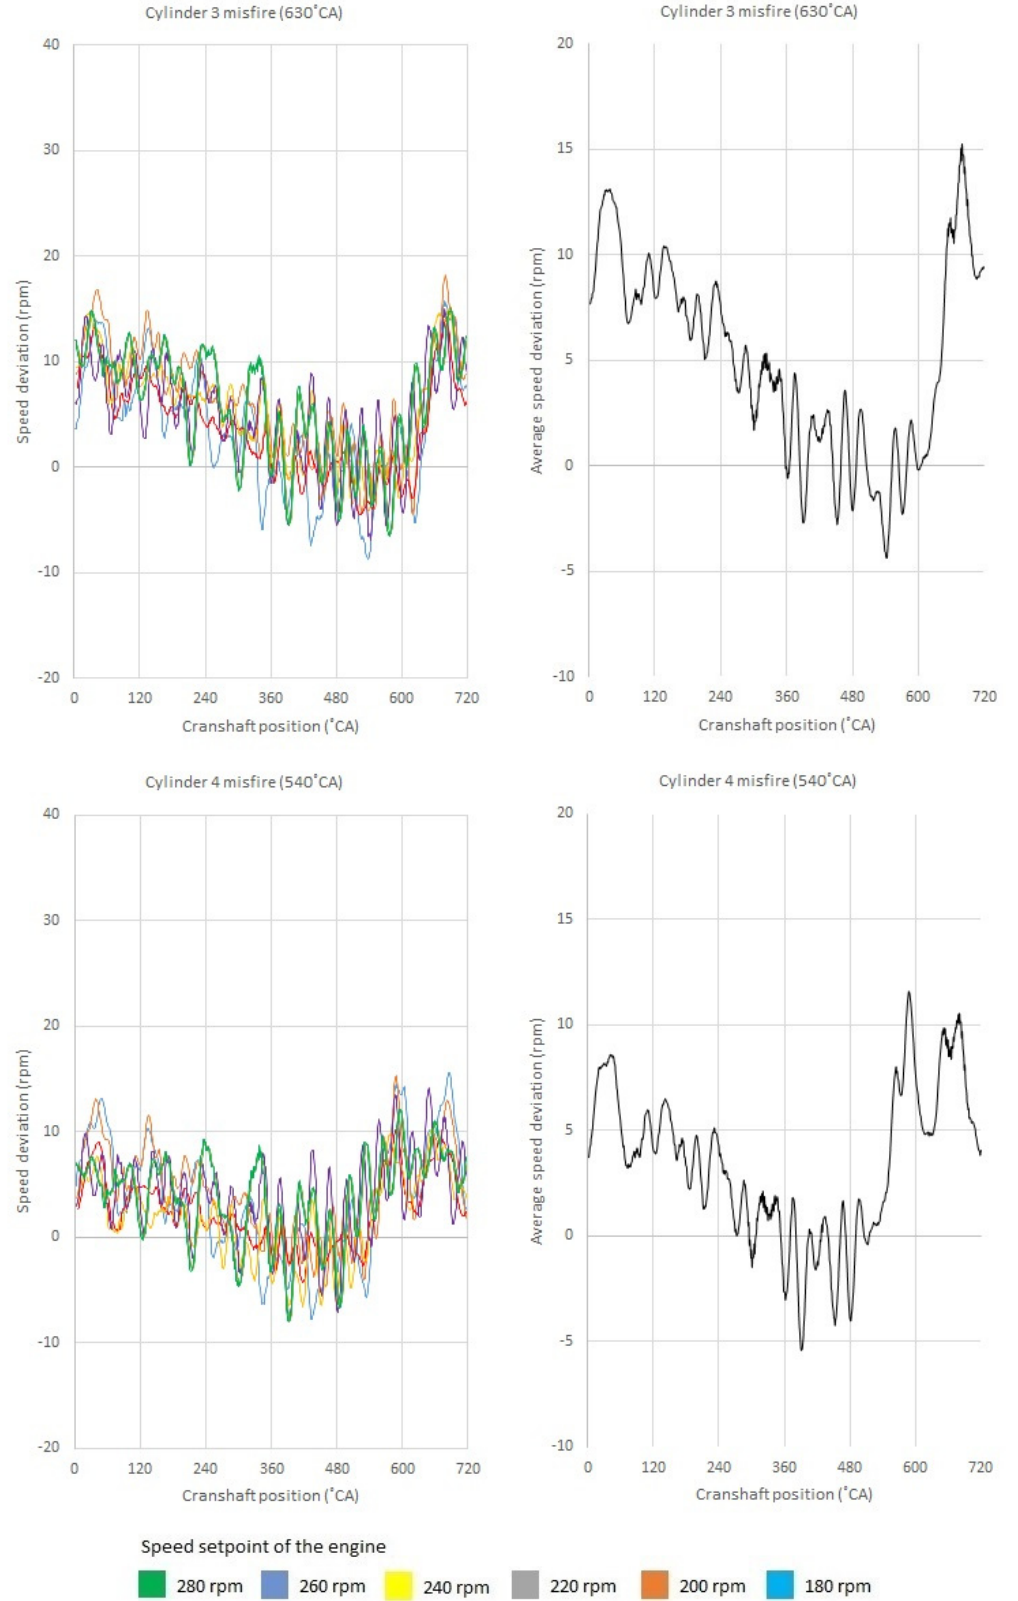
Figure 16. Instantaneous speed differences and the average deviation of the combustion loss in cylinders 3 and 4 of the Buckau-Wolf R8DV-136 engine.